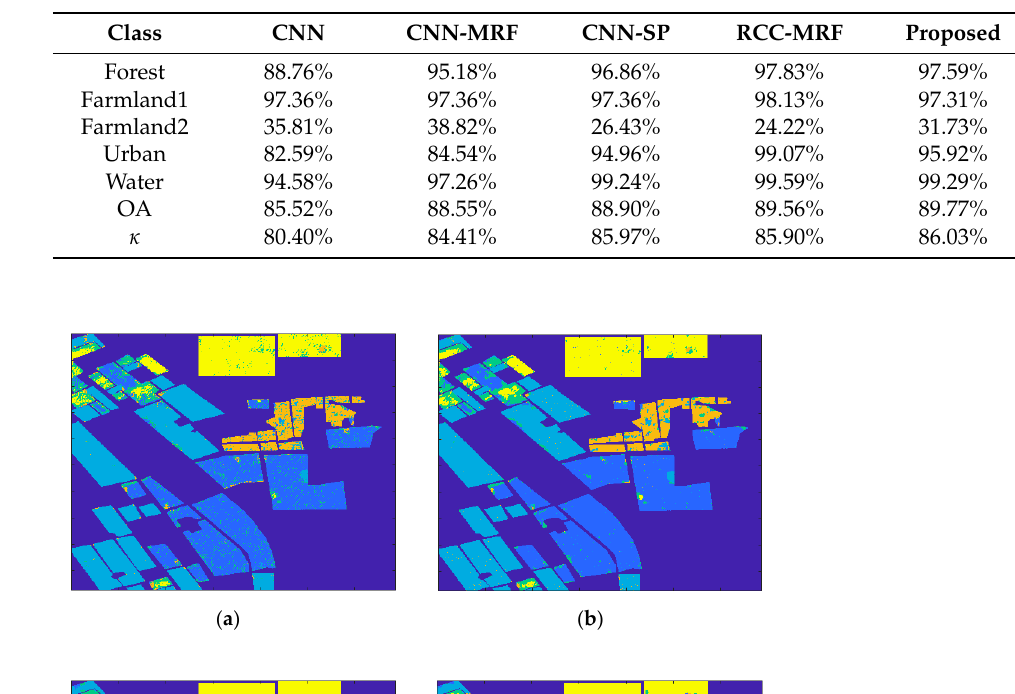
Table 4. Accuracies of classification on Flevoland image.